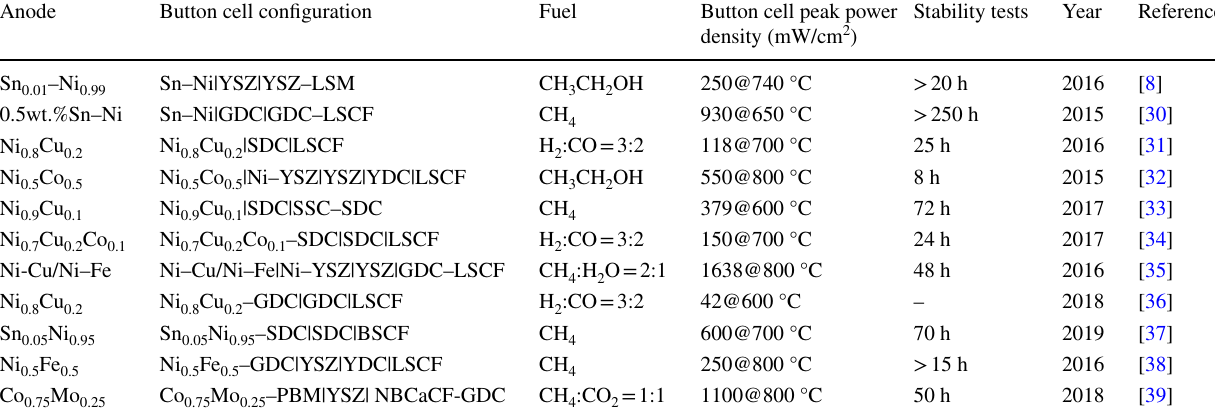
Table 3 Comparison of electrochemical performance of button cells with alloy anodes